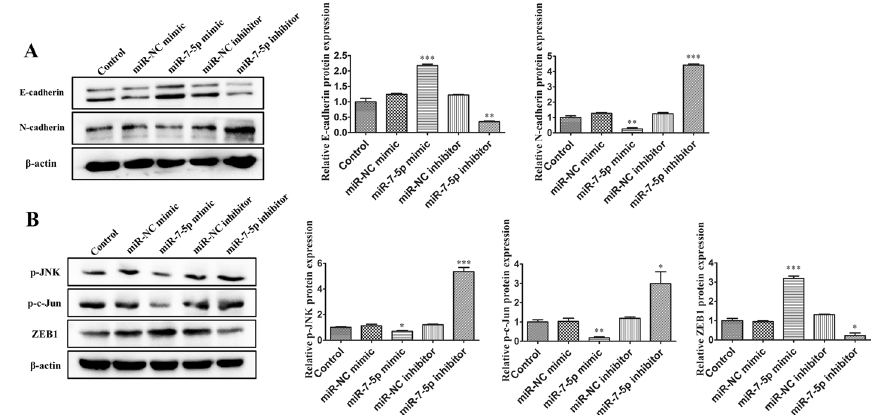
Fig. 5 Hsa-miR-7-5p is involved in the JNK-mediated atypical WNT signalling pathway and significantly inhibits breast cancer metastasis. A Western blot analysis of E-cadherin and N-cadherin protein expression levels after treatment of MDA-MB-231 cells with blank controls or miR-7-5p mimics, inhibitors and their negative controls. B Western blot analysis of p-JNK, p-c-Jun and ZEB1 protein expression levels after treatment of MDA-MB-231 cells with blank control or miR-7-5p mimics, inhibitors and their negative controls. Data are presented as mean SD ( n 3). * p < 0.05, ** p < 0.01, *** p < ± =